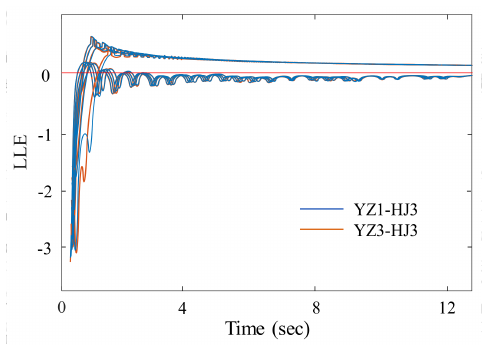
Figure 12. LLE–time curves with different fault clearing time for the mentioned fault scenario of ECG.